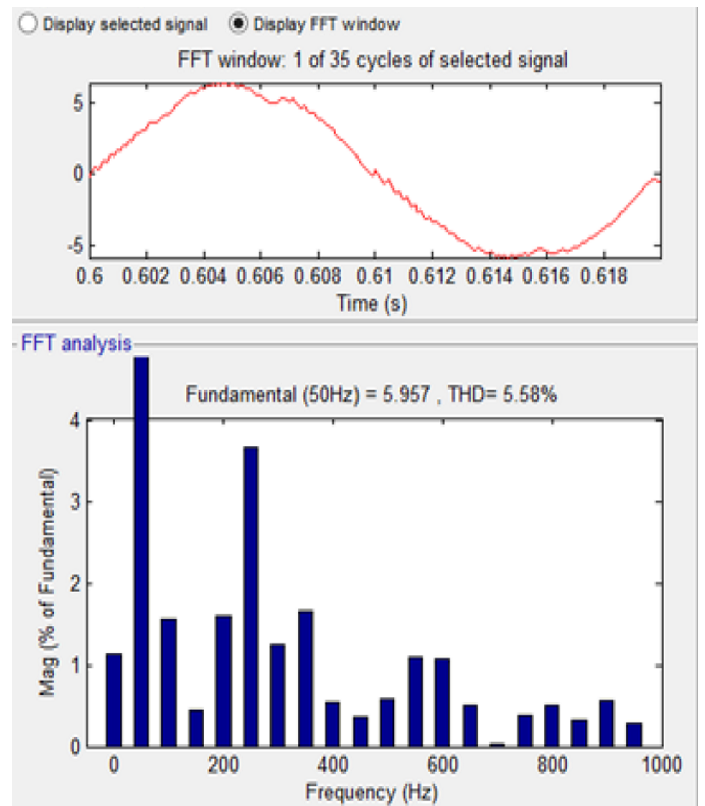
Figure 17. FFT analysis of the system after integrating MG1 and